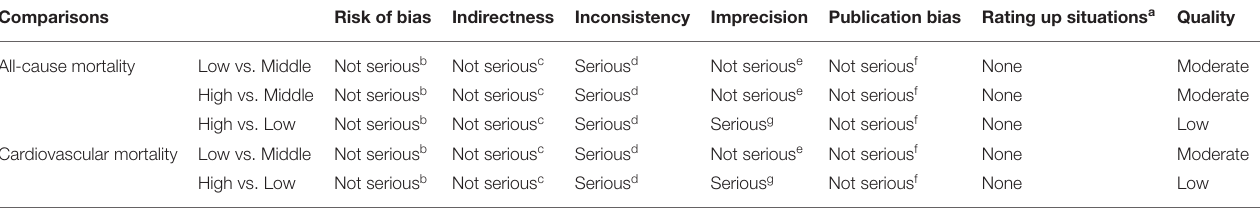
TABLE 5 | GRADE assessment of the quality of evidence.